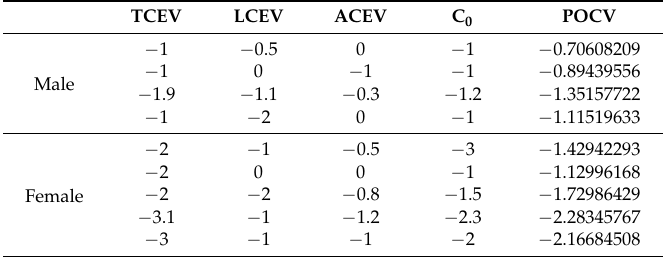
Table 6. Model verification data